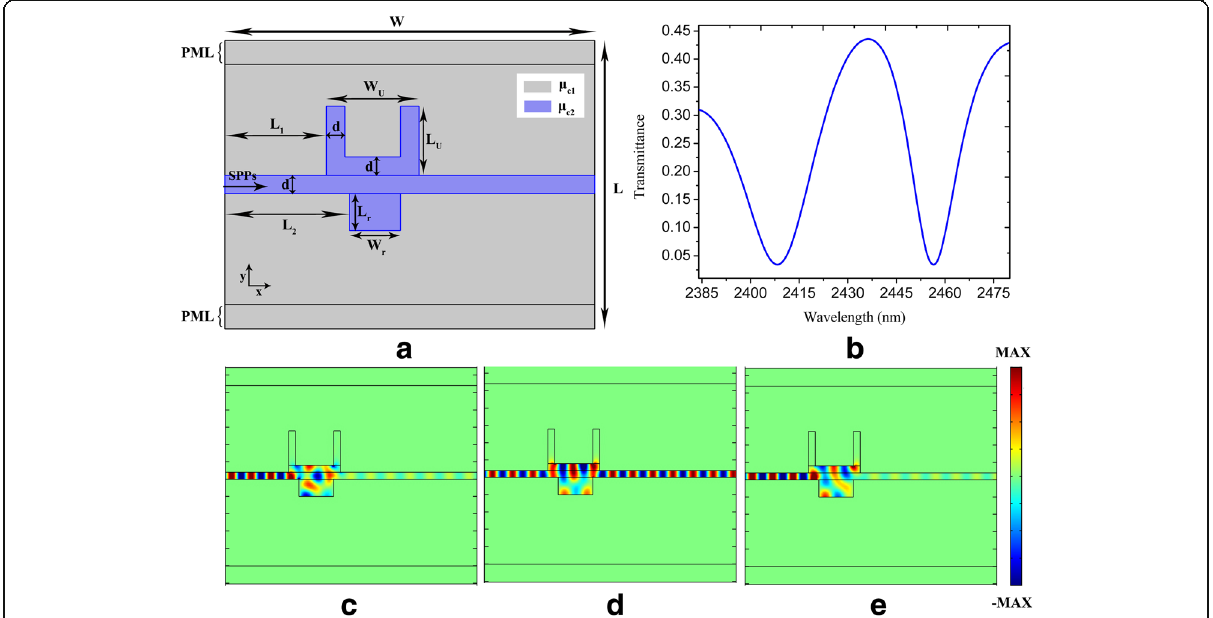
Fig. 3 a, b The schematic configuration and the geometric parameters of U-shaped and rectangular nanocavity-coupled waveguide system and the corresponding spectral transmittance respectively. c – e Electric field ( E y ) distribution at wavelengths of 2408, 2437, and 2457 nm respectively. The parameters are set as W = 800 nm, L = 620 nm, d = 20 nm, W U = 150 nm, L U = 120 nm, L 1 = 220 nm, L 2 = 250 nm, L r = 50 nm, W r = 100 nm, τ = 1 ps, μ μ c1 = 0.3 eV, and c2 = 0.9